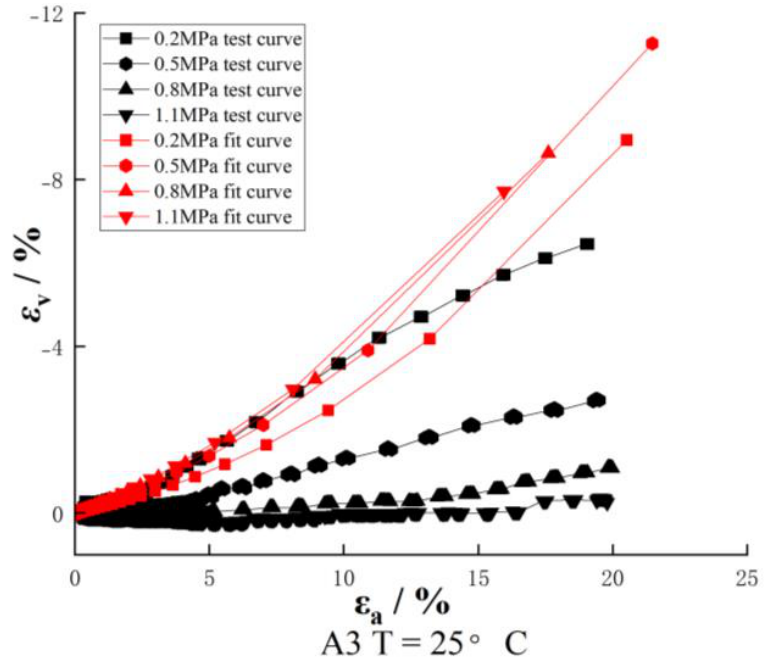
Figure 6. The fitting results are compared with the experimental Figure 6 . The fitting results are compared with the experimental results .